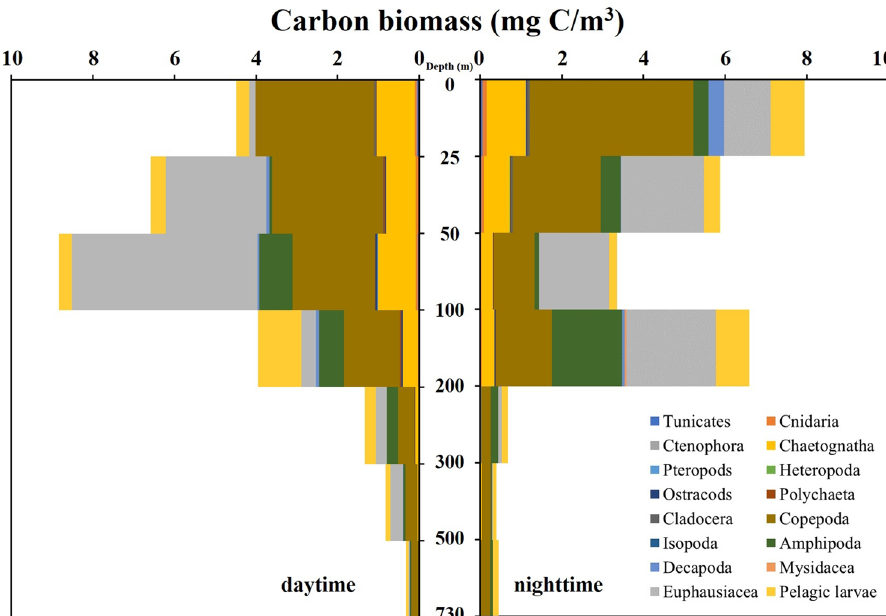
Figure 6. The diel vertical variations of zooplankton carbon biomass in the Caroline Seamount area on June 2 to 3, 2019.